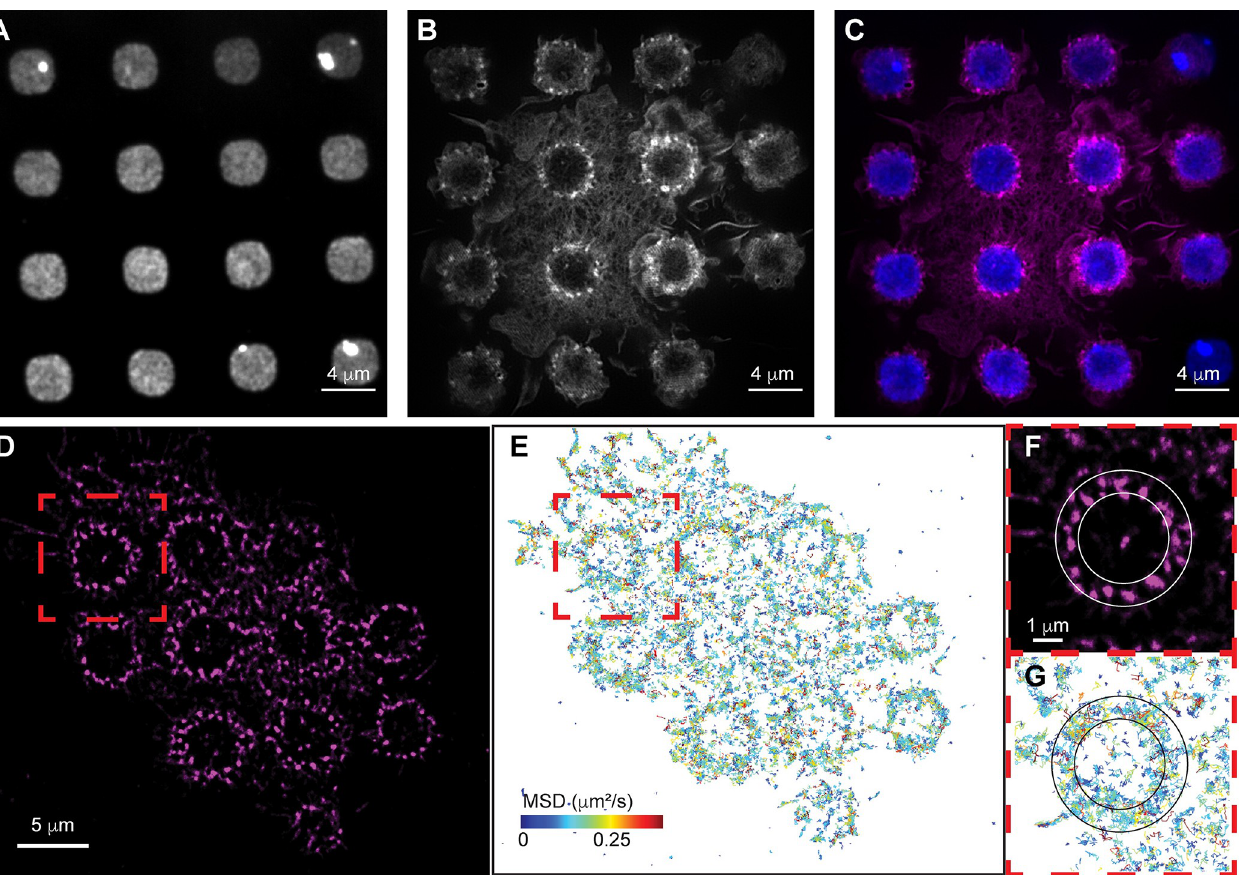
Fig 1. Actin and Cdc42 localization around disks of IgG during frustrated phagocytosis. A-C) Rosettes of actin podosomes form around IgG disks in RAW 264.7 macrophages. A micropattern of IgG disks of diameter 3.5 μ m is shown in A . Actin is shown in B , in which puncta are podosomes. An overlay (IgG in blue, actin in magenta) is shown in C . D-G) Single particle tracking (SPT) of Cdc42 during frustrated phagocytosis. Actin is shown in D . SPT of Cdc42 is shown in E , with tracks colored by their mean squared displacement (MSD, distribution of MSDs is shown in S1C Fig). An individual rosette of actin (red box in D ) is shown expanded in F . For this same actin rosette, Cdc42 SPT (red box in E ) is shown expanded in G (same MSD coloring as in E ). Rings shown in F,G are to aid in visualization of the increased track density where actin podosomes form.